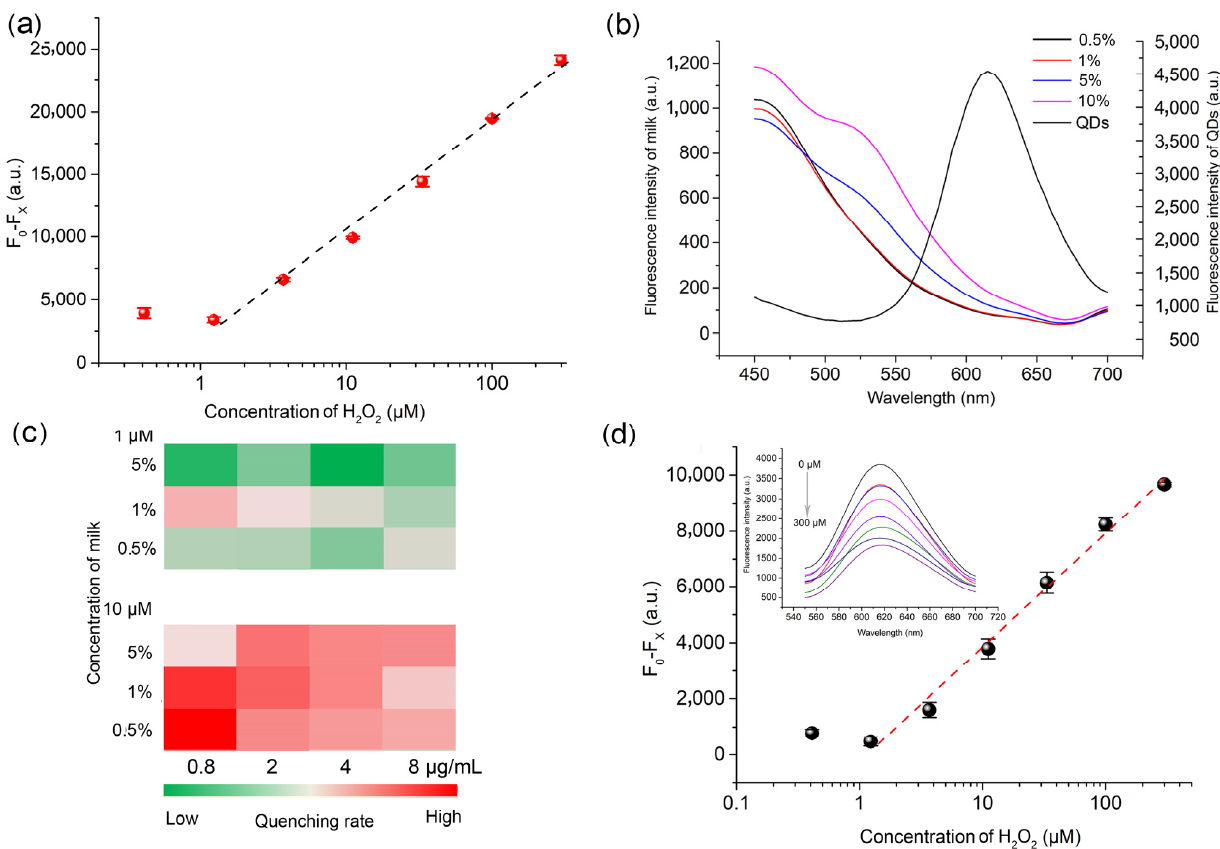
Figure 2. Detection of H 2 O 2 by GSH-CdTe QDs in milk. Calibration curve for detection H 2 O 2 in water ( a ); Fluorescence spectra of milk and GSH-CdTe QDs ( b ); Optimization results of milk and GSH-CdTe QDs concentration ( c ); And linear standard curve for H 2 O 2 detection in Milk (Insert: Fluorescence spectra of GSH-CdTe QDs at each H 2 O 2 concentration) ( d ).